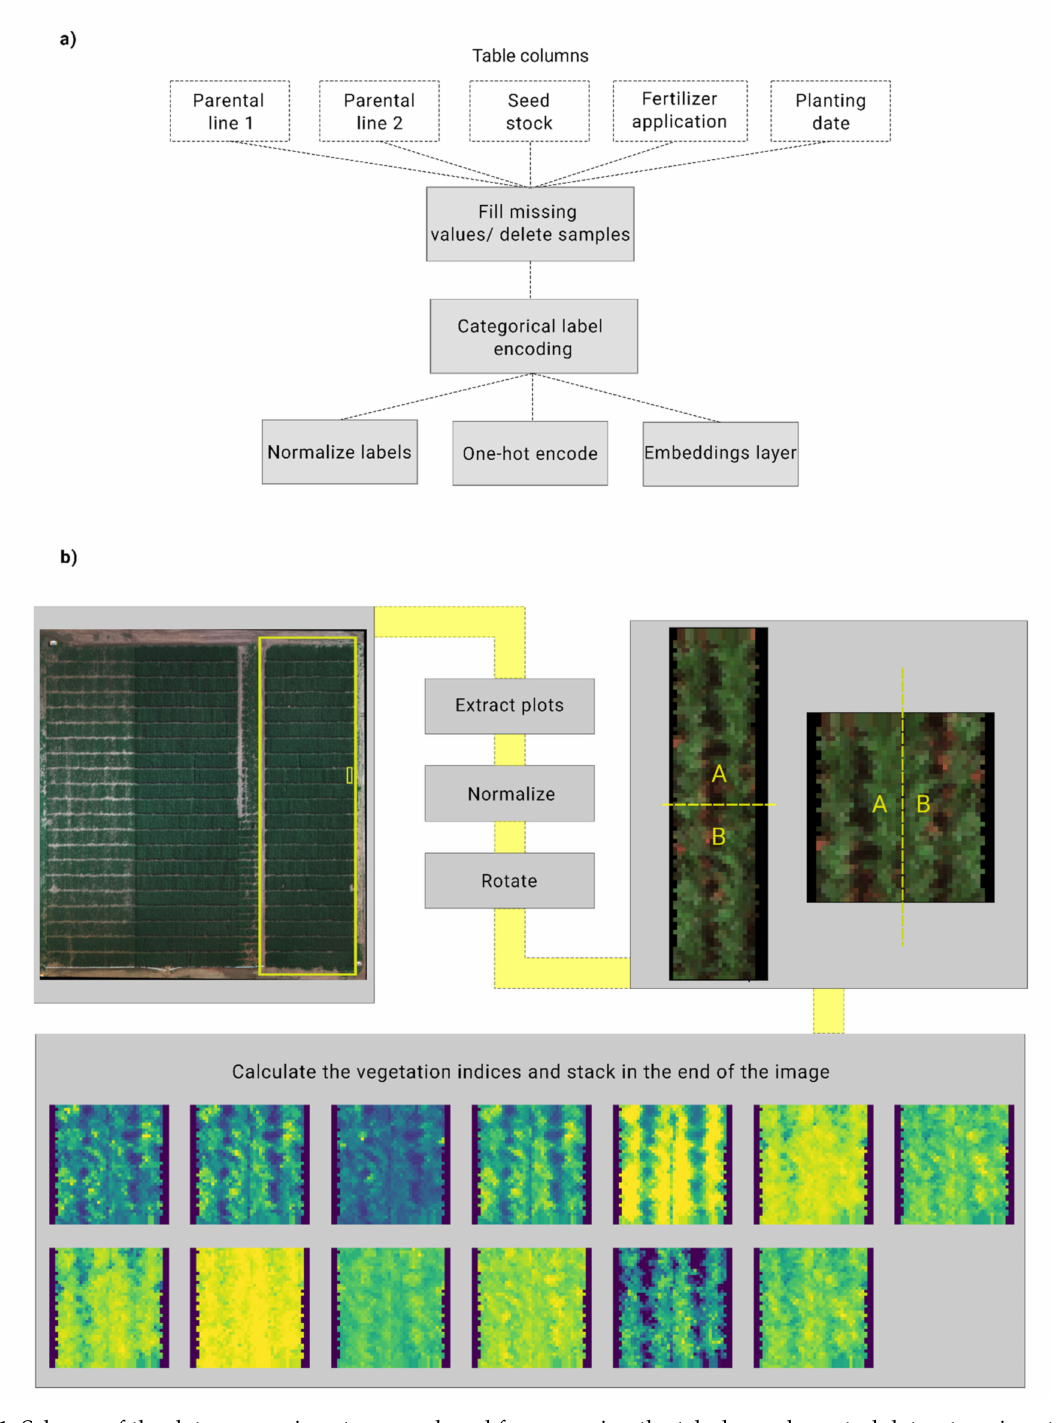
Figure 1. Scheme of the data processing steps employed for preparing the tabular and spectral datasets as input for the machine learning models. ( a ) Tabular data processing; categorical feature columns were subjected to the steps listed, they were then normalized, one-hot encoded, or used in embedding layers for testing. ( b ) Multispectral image processing. The images collected by the UAV were used to build the orthomosaic, the individual maize plots were then extracted, the pixel values were normalized and, finally, the plot was cut and stacked in random order. The vegetation indices were calculated as new spectral bands, and are shown in the image in the following order: blue, green, red, red edge, NIR, NDVI, NDVI-RE, NDRE, ENVI, CCCI, GNDVI, GLI and